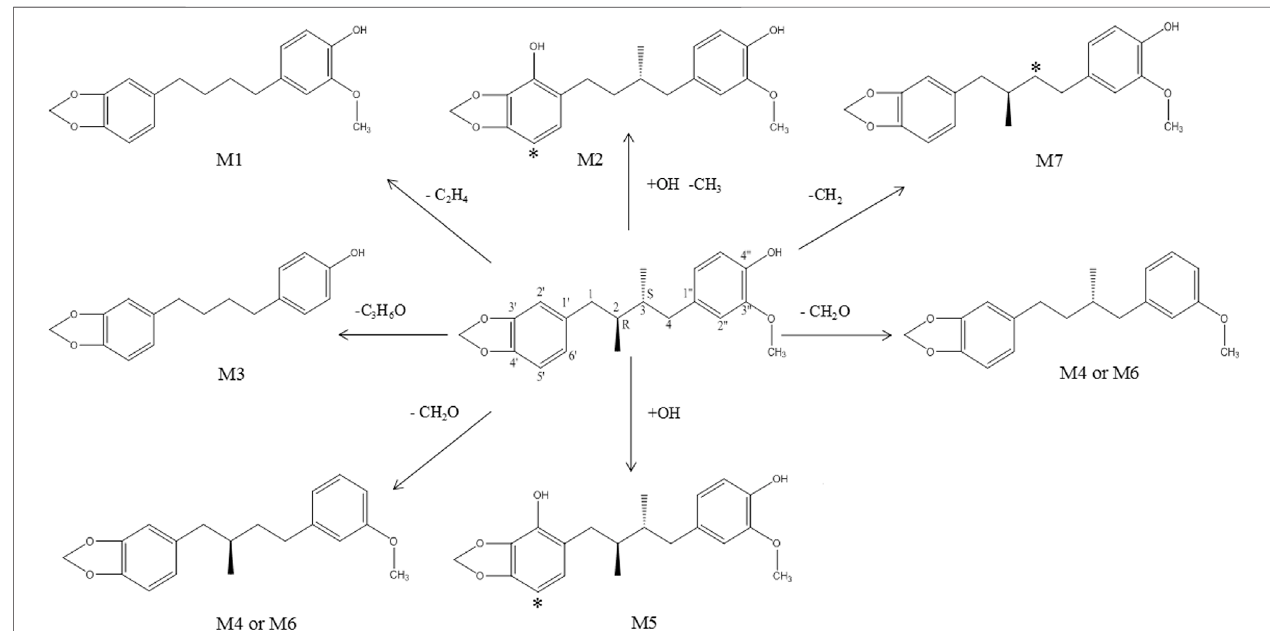
FIGURE 9 | Proposed metabolic pathway of anwulignan in mice. Note: * the potential metabolic site.